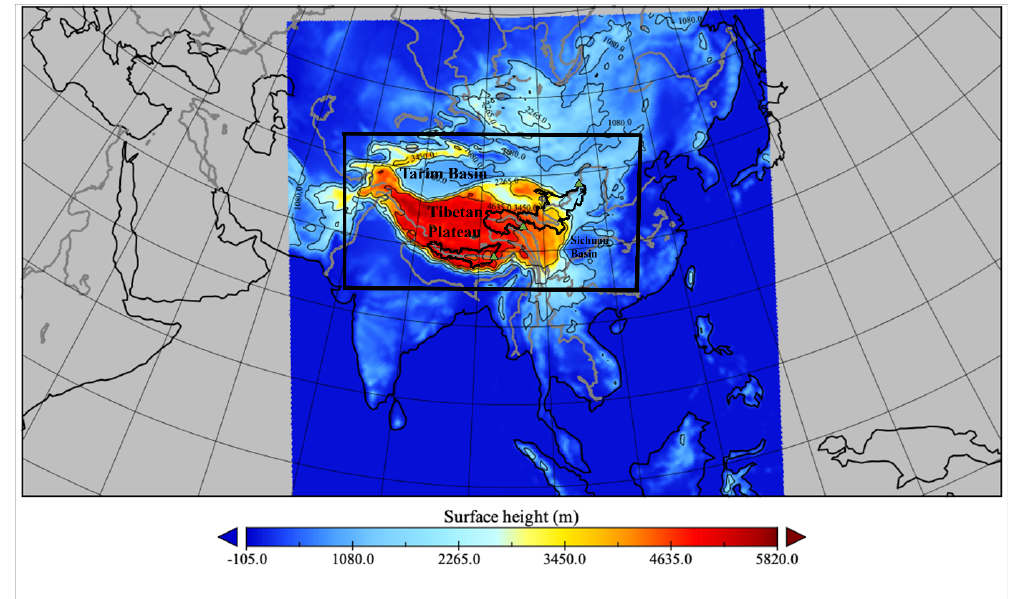
Figure 1. Topography (m) in the outer WRF domain, as well as the major rivers and lakes (grey). The black rectangle represents the inner WRF domain. Black curves denote outlines of the UBB, UYAB, and UYEB at the left, middle, and right. Green triangles inside each basin denote the Yangcun (left), Zhimenda (middle), and Tanglai Qu (right)